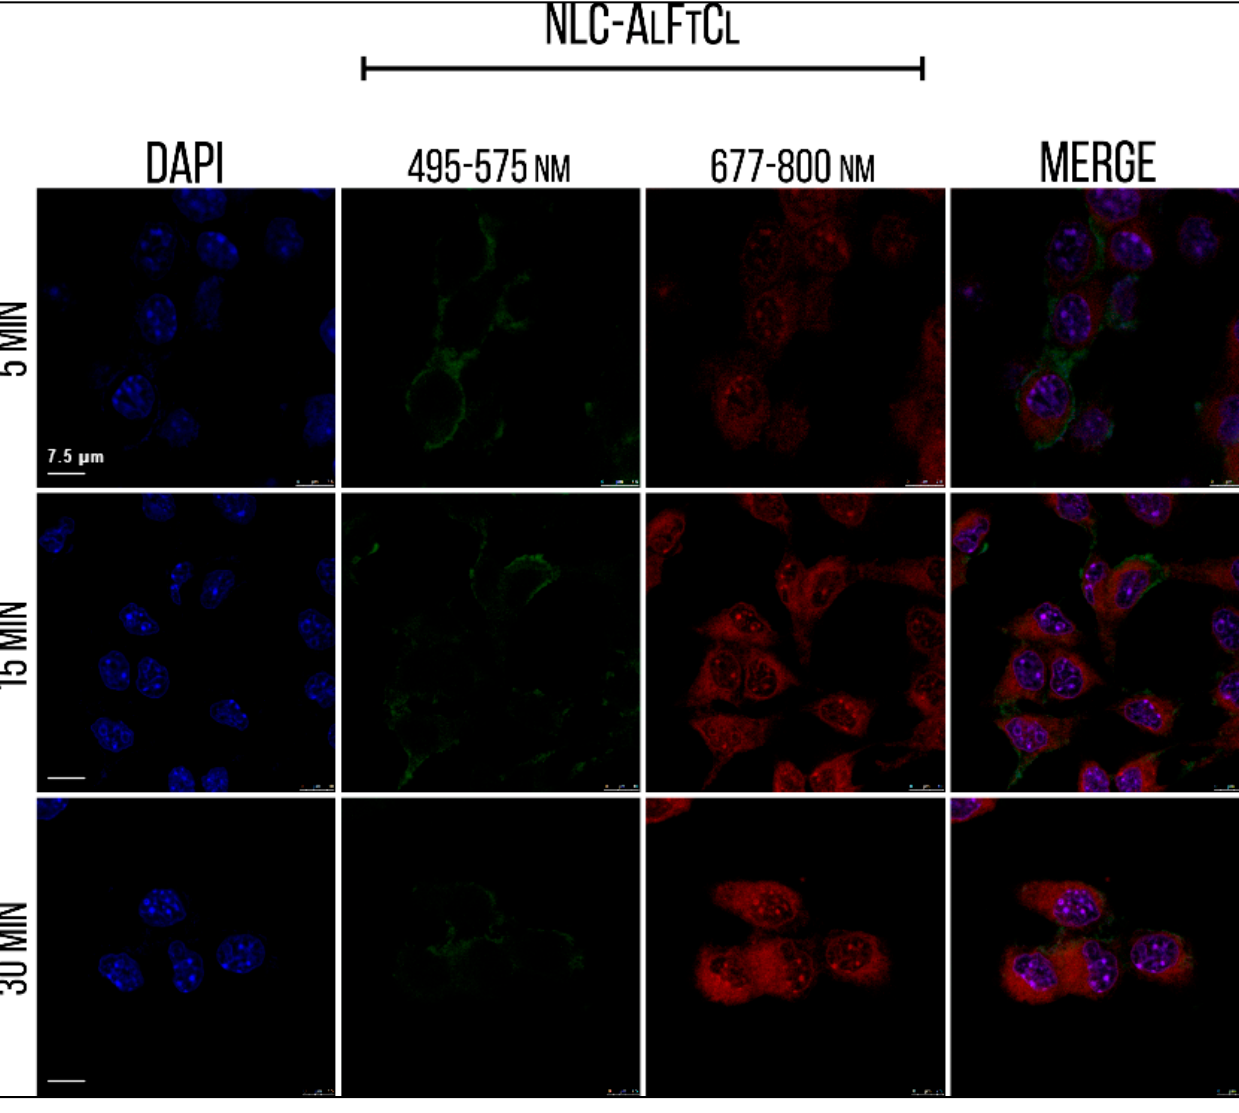
Figure 9. Internalization of SLN-AlPc after 5, 15, and 30 min of treatment. The nucleus (blue), the SLN-AlPc (green), and the AlPc (red) are demonstrated in the image. It was observed that only cells treated with the inhibitor amiloride showed a decreased AlPc- specific fluorescence intensity, indicated by a shift to the left, which is indicated in Figure 10. This shows that macropinocytosis maybe the main contributor to the nanocarrier internalization. This pathway is characterized by the movement of the plasma membrane induced by a global activation of the actin cytoskeleton. This pathway involves the transposition of a large amount of external colloid through the formation of ripples along the plasma membrane. Cytoplasmic projections merged into the membrane as waves, resulting in large endocytic vacuoles, heterogeneous in size and morphology, called macropinosomes [46]. The colocalization of SLN-AlPc with the cytoskeleton (Figure 11) and the visualization of spherical actin structures after exposure of B16-F10 cells to the carrier (Figure 12), suggesting macropinosomes, confirmed the occurrence of endocytosis of SLN-AlPc mediated by